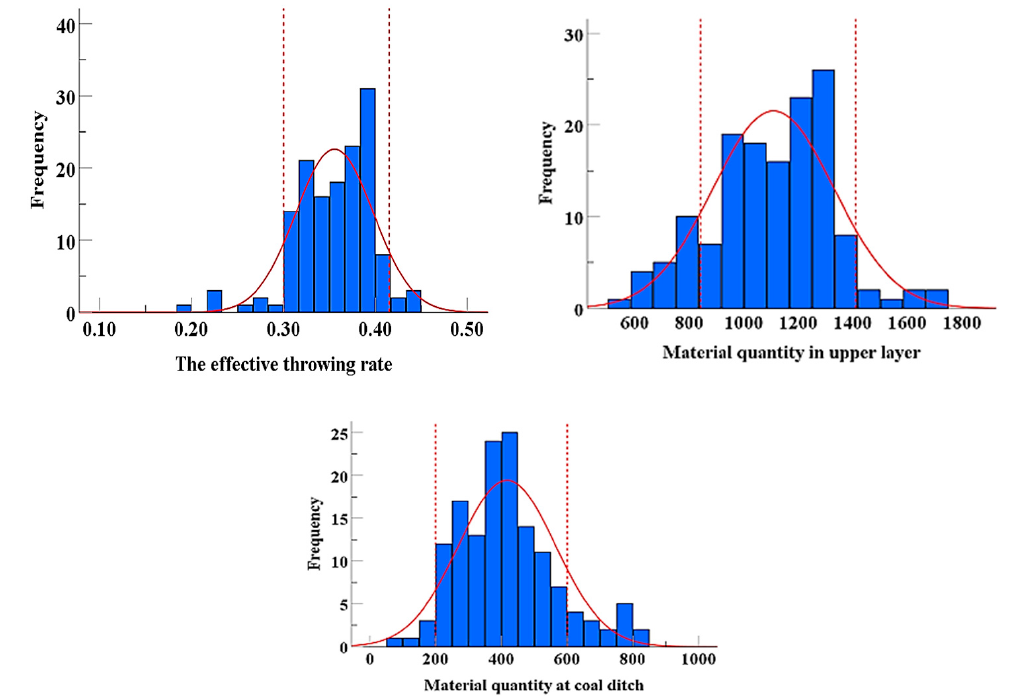
Figure 10. Statistical analysis of a sample set with step height of 35 m.